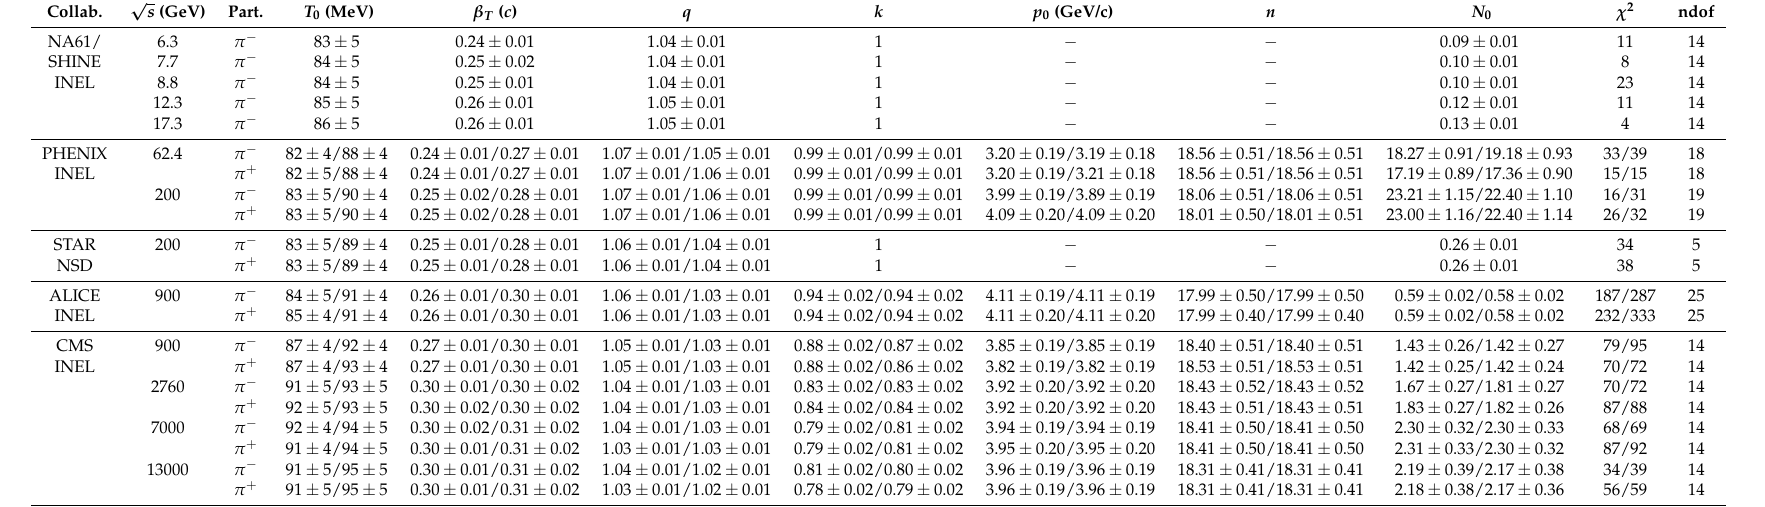
Table 4. Values of T 0 , β T , q , k , p 0 , n , N 0 , χ 2 , and ndof corresponding to the dashed (dot-dashed) curves for π − ( π + ) spectra in Figure 4, where Equation (8) through Equations (2) and (3) is used. √ s (GeV) Collab.